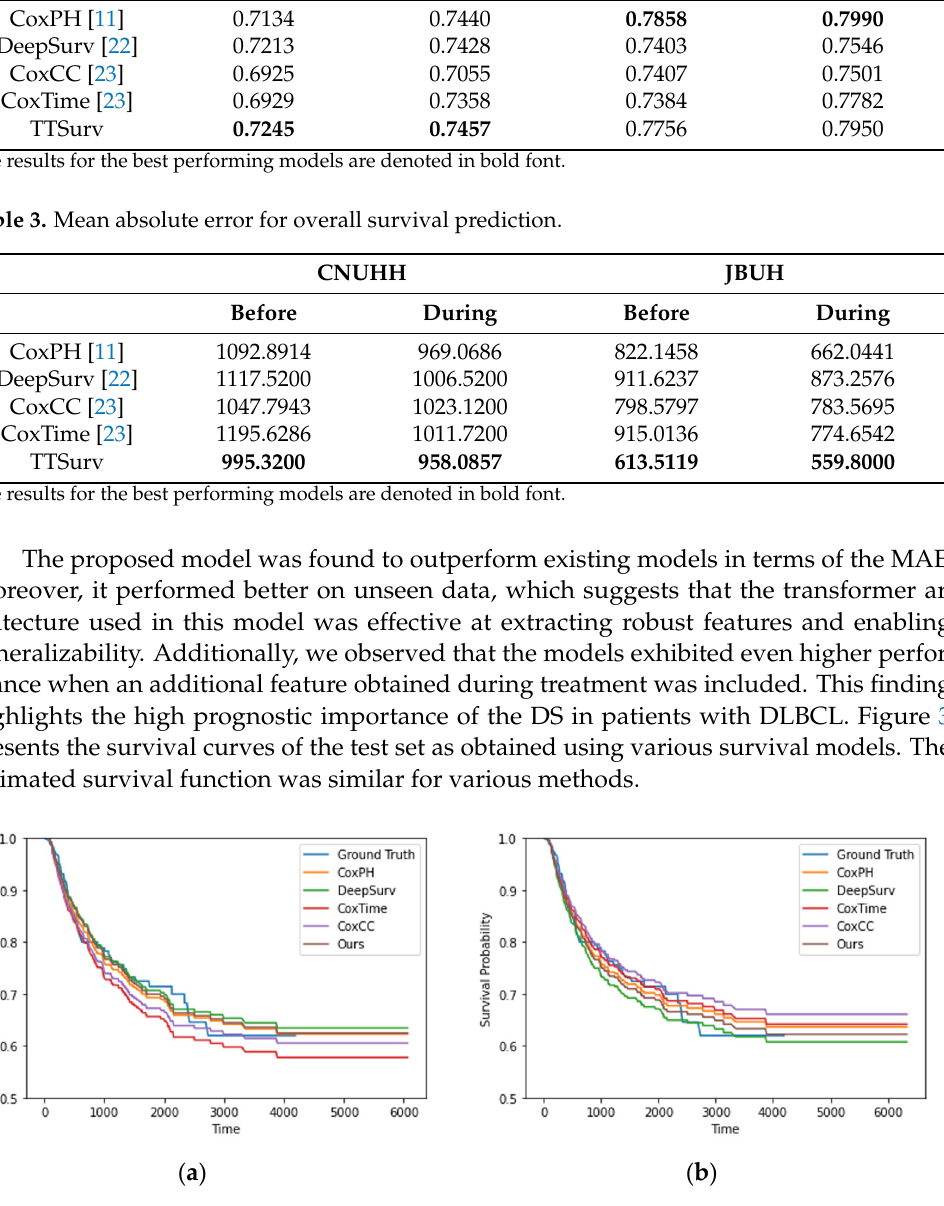
Table 4. Example predictions for patients with survival times in the range of 527–2421 days.